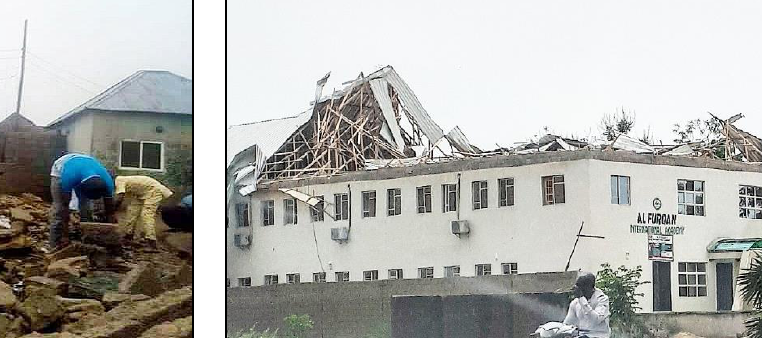
Figure 7. Damage walls (Residential) Figure 8. Damage roof (Institutional)